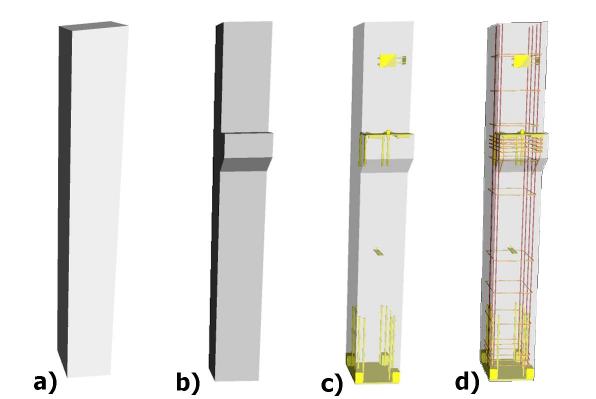
Figure 2. Example of LoD levels (Precast Struc tural Column - Concrete): a) LoD200, b) LoD300, c) LoD350, d) LoD400